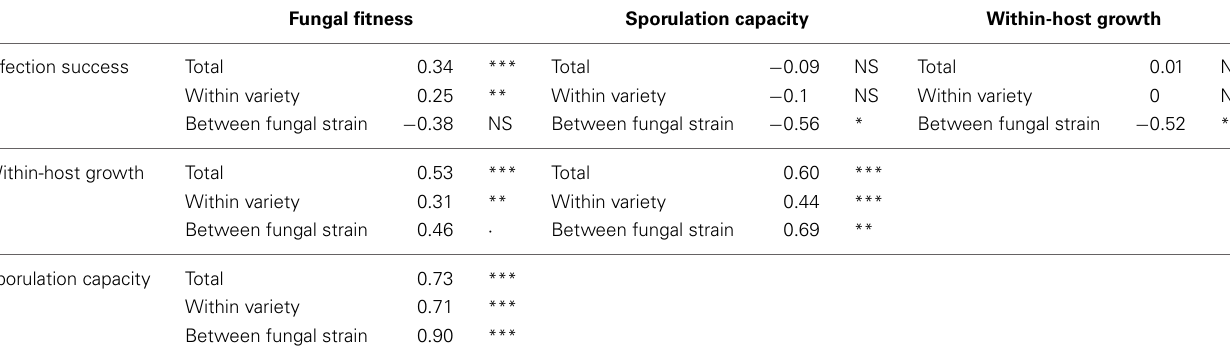
Table 3 | Correlation table on the three varieties Ariete, CO39, and